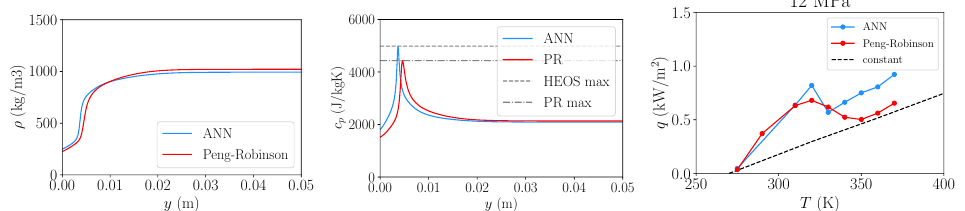
Figure 8. Fluid properties in the boundary layer for a wall temperature of T w = 390 at a pressure of p = 12 MPa comparing the ANN (blue) simulation to the Peng–Robinson (red) simulation. Left: density profile; Right: heat capacity profile; Right: average heat flux along the flat plate for heated flat plate of different wall temperatures.